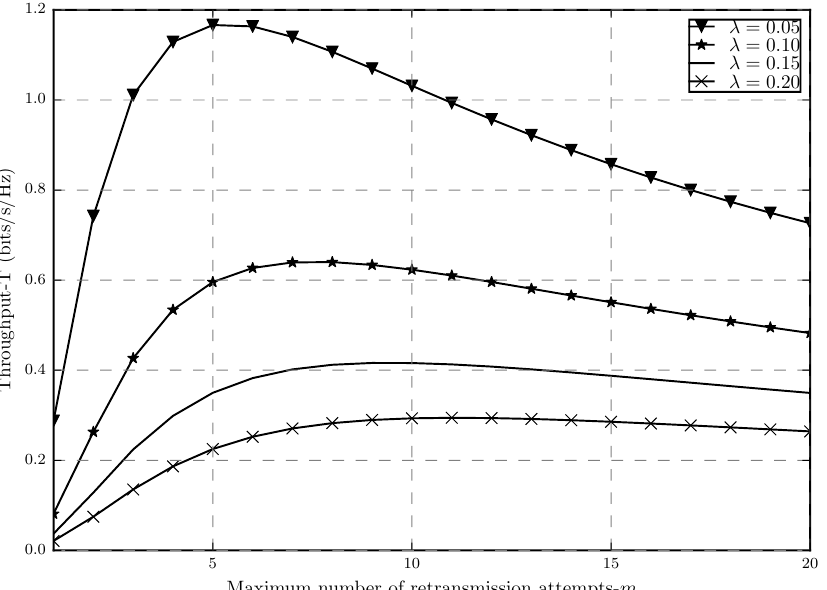
Figure 6. Throughput T versus the maximum number of allowed retransmission attempts m for α = 4, r 0 = 1, (cid:101) = 0.02 and different densities λ